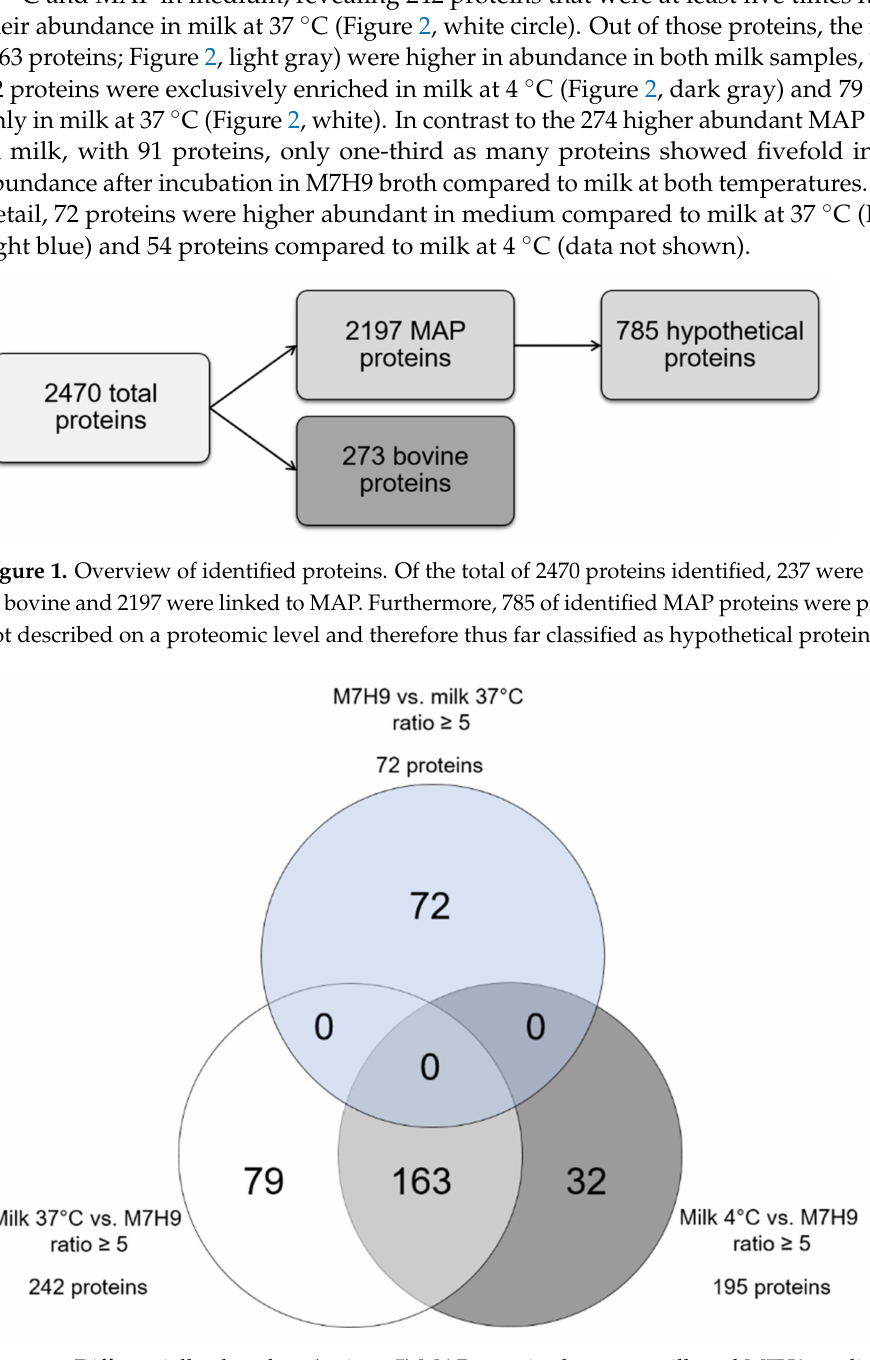
Figure 2. Differentially abundant (ratio ≥ 5) MAP proteins between milk and M7H9 medium. After incubation in milk at 37 ◦ C (white circle) and 4 ◦ C (gray circle), a total of 274 MAP proteins were at least fivefold higher in abundance compared to incubation in M7H9 broth. Most of the proteins (163, light gray) were enriched in milk at both temperatures, while 79 showed increased abundance only in milk at 37 ◦ C (white) and 32 proteins only in milk at 4 ◦ C (dark gray). In contrast, 72 proteins were at least fivefold higher abundant in M7H9 broth compared to milk at 37 ◦ C